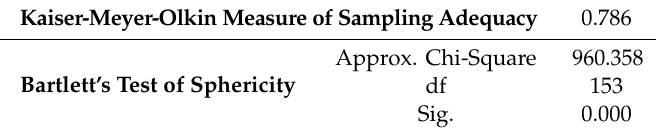
Table 5. Kaiser-Mayer-Olkin (KMO) sampling adequacy and Bartlett’s